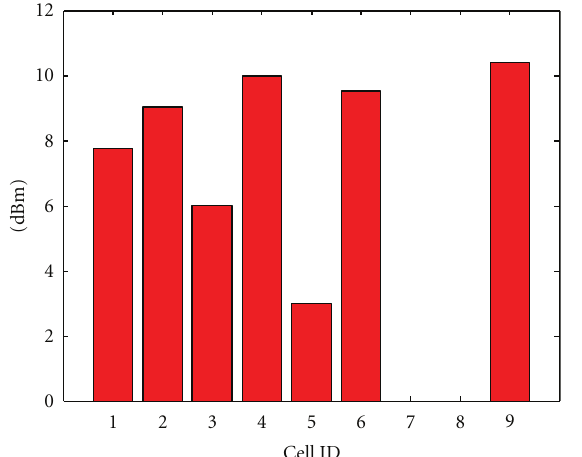
Figure 9: Converged pilot power setting of the femtocells (no. of FBSs = 9).